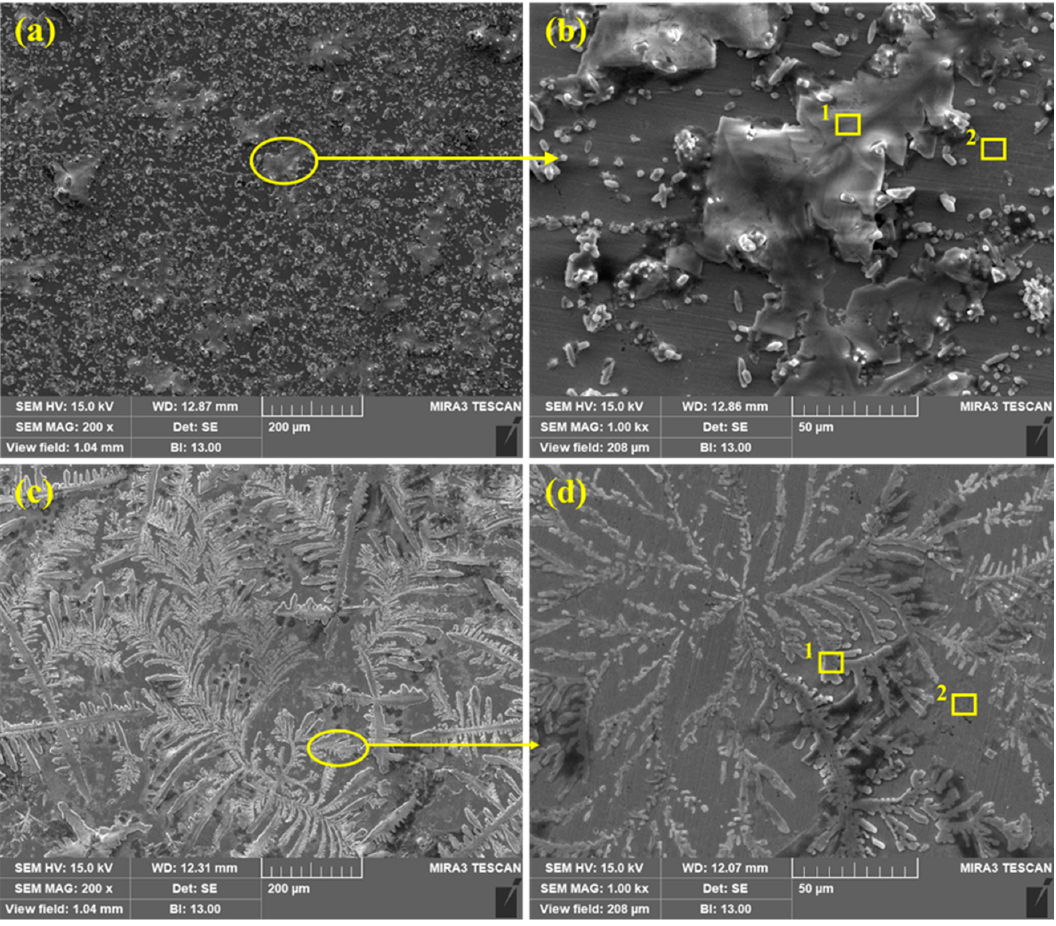
Figure 8. SEM of steel rebar after 120 h of exposure in bare (( a ) at 200× and ( b ) at 1000×) and 3% inhibitor- (( c ) at 200× and ( d ) at 1000×) added 3.5% NaCl contaminated concrete pore solutions. inhibitor- (( c ) at 200 × and ( d ) at 1000 × ) added 3.5% NaCl contaminated concrete pore Table 4. EDS of steel rebar sample after 120 h of exposure in bare and 3% inhibitor-containing SCP + 3.5 wt% NaCl solution.